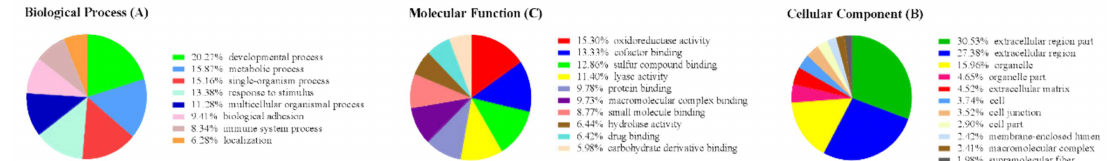
Figure 3. Gene ontology analysis of di ff erently-expressed protein after mangiferin treatment.